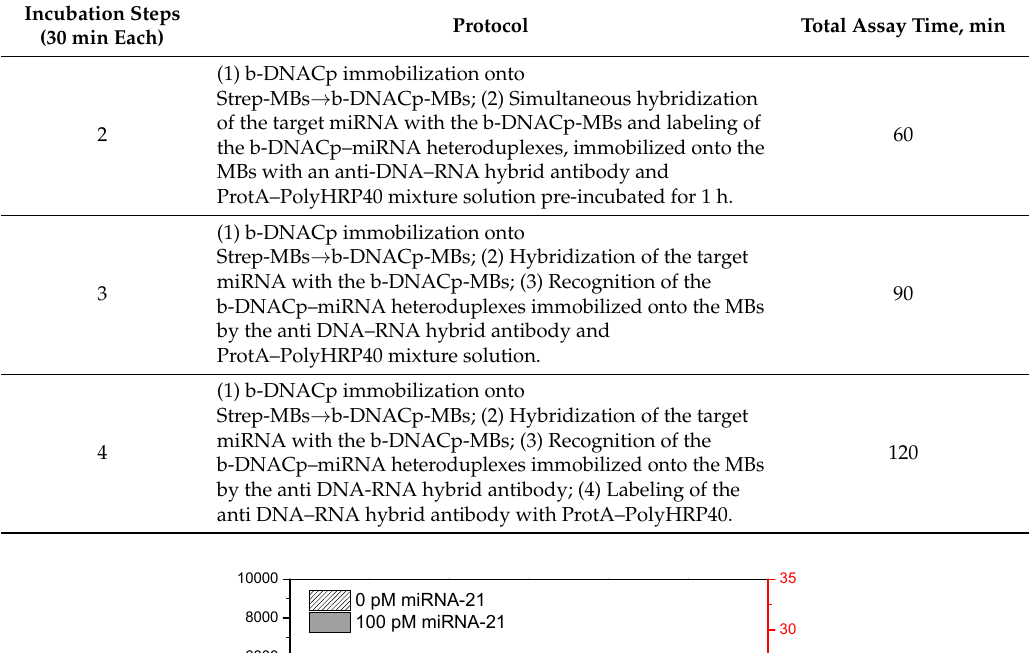
Table 2. Working protocols evaluated to prepare the amperometric biosensor for the determination of miRNA-21.